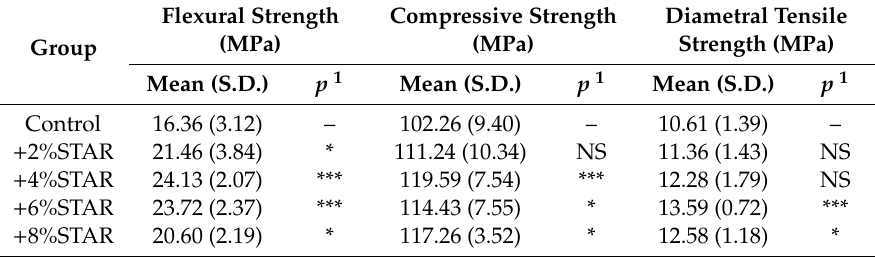
Table 1. Results of flexural strength, compressive strength, and diametral tensile strength tests.